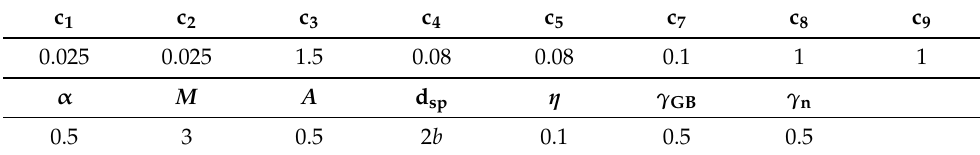
Table 2. Material data used in the microstructure model for hot rolling in Equations (7)–(10). c